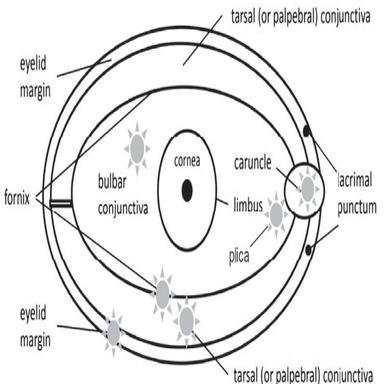
Anatomic scheme of the conjunctiva.